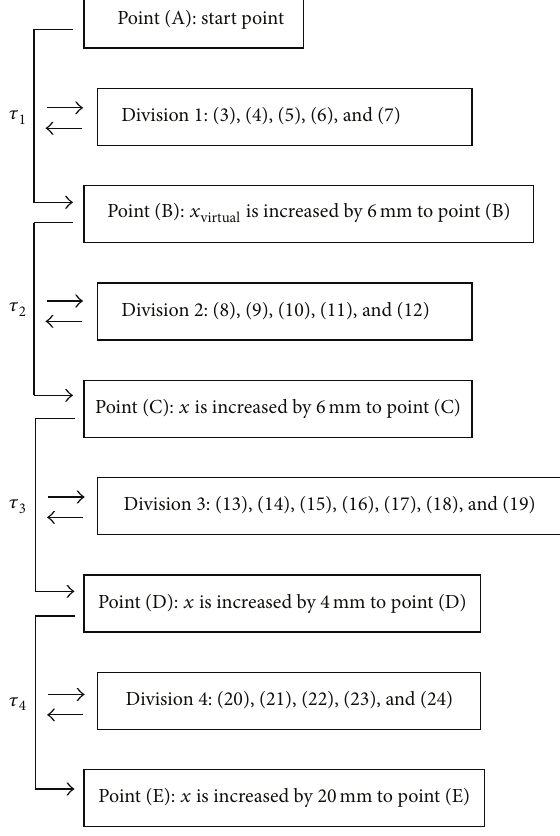
Figure 12: Flowchart for solving response time.